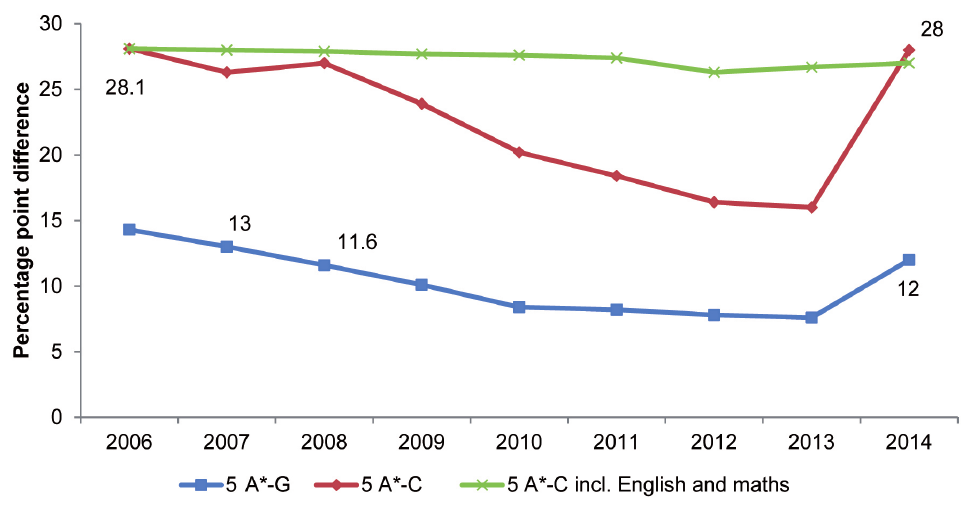
Figure 2: Gaps between proportions of FSM and non-FSM students achieving different thresholds at GCSE, 2006–2014